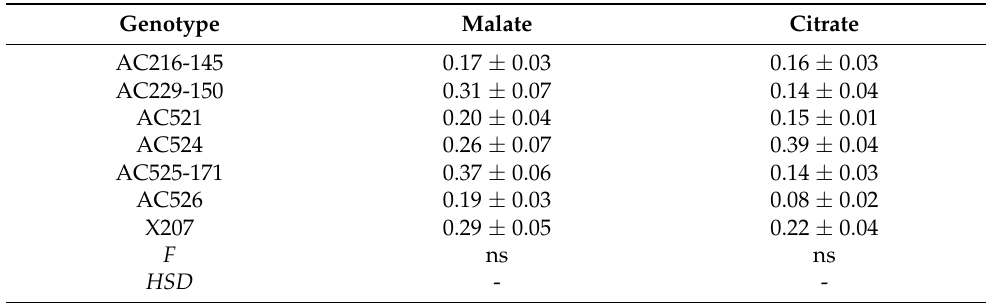
ns, not significant. Table 4. Root protein content in accession AC521 and the hybrid X207 ( P. ahipa × P. tuberosus ). Lipids and fibers determined only in ahipa AC521. Mean ± standard deviation. Values in g × 100 g dry matter − 1 .